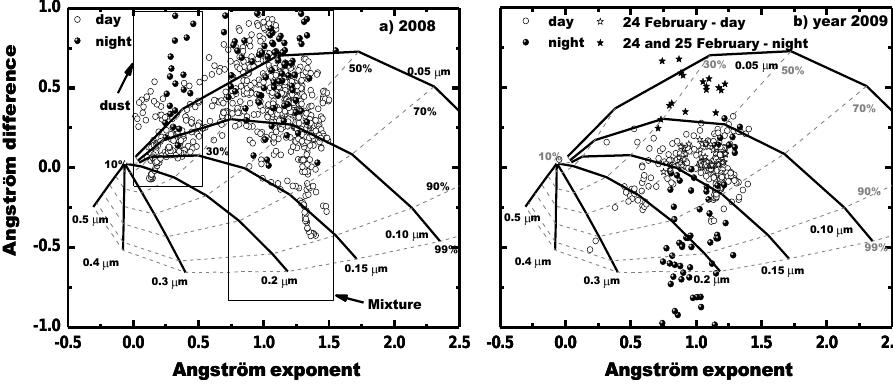
Fig. 8. Angstr¨om exponent difference δα = α (440–670nm) − α (670–870nm) as function of α (440–870nm) at daytime and δα = α (436–670nm) − α (670–880nm) as function of α (436–880nm) at nighttime, for the winter season. (a) For year 2008. (b) For year 2009. Each point presented in that figure corresponds to a single measurement with sun-photometry or 30min average measurements with star-photometry.